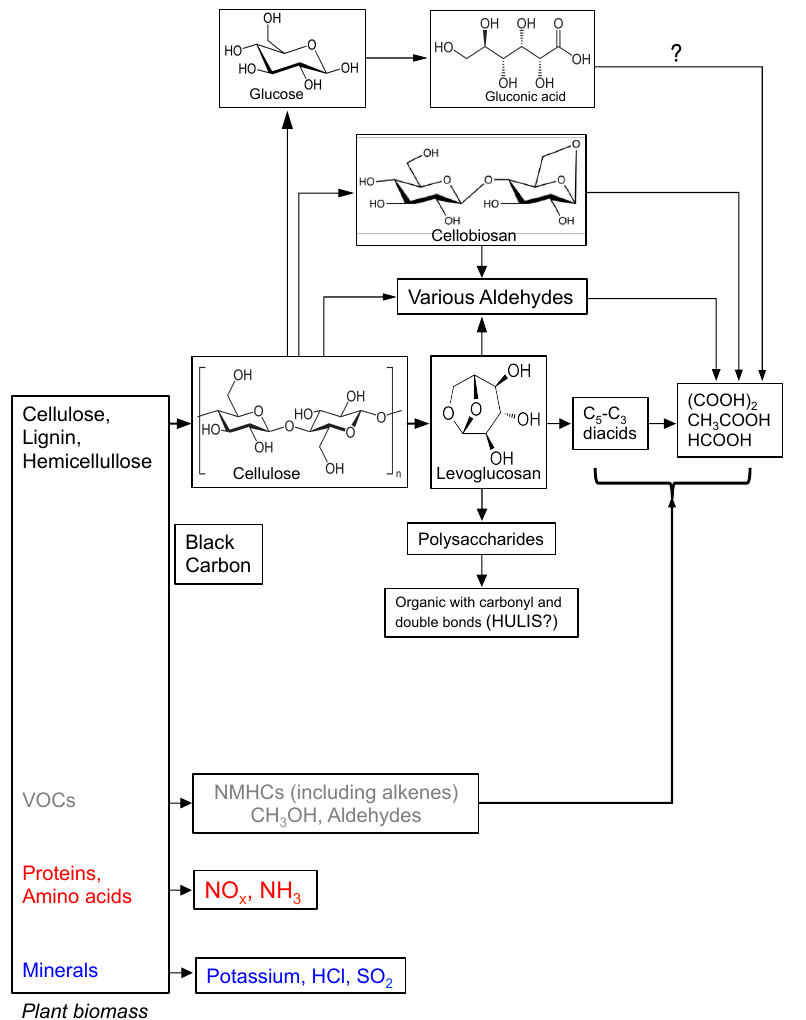
Figure 1. Proposed chemical pathways for formation of various chemical species identified in smoke aerosols. Adapted from Gao et al. (2003) and references therein, Kawamoto et al. (2003), and Abella et al. (2007).